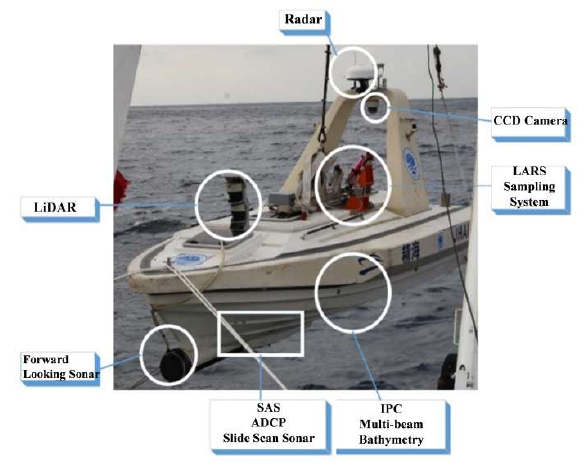
Figure 3. Device installation